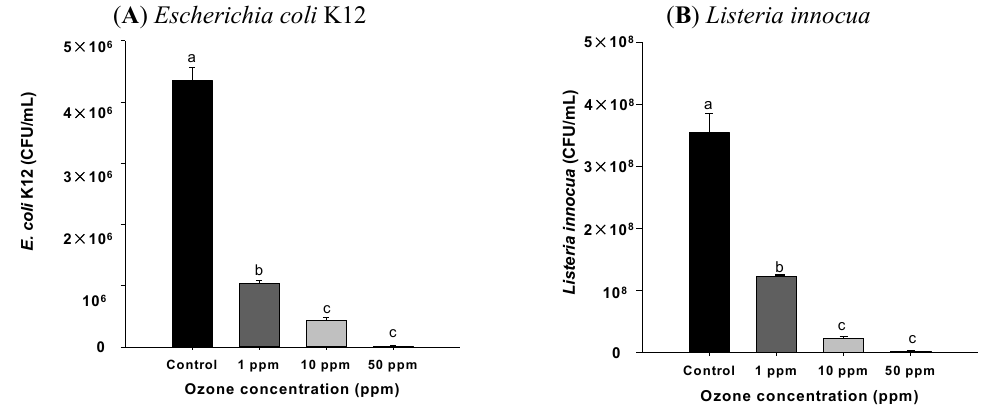
Figure 1. Impacts of ozone treatment on ( A ) E. coli K12 and ( B ) L. innocua (CFU/mL) grown on agar plates. The treatment chamber was ventilated with 1, 10, or 50 ppm ozone for 10 min. Controls were exposed to “clean air”. Values represent the mean (± Standard Error) of measurements made on three independent plates per treatment. Bars with different letters are statistically significantly different ( p < 0.05).